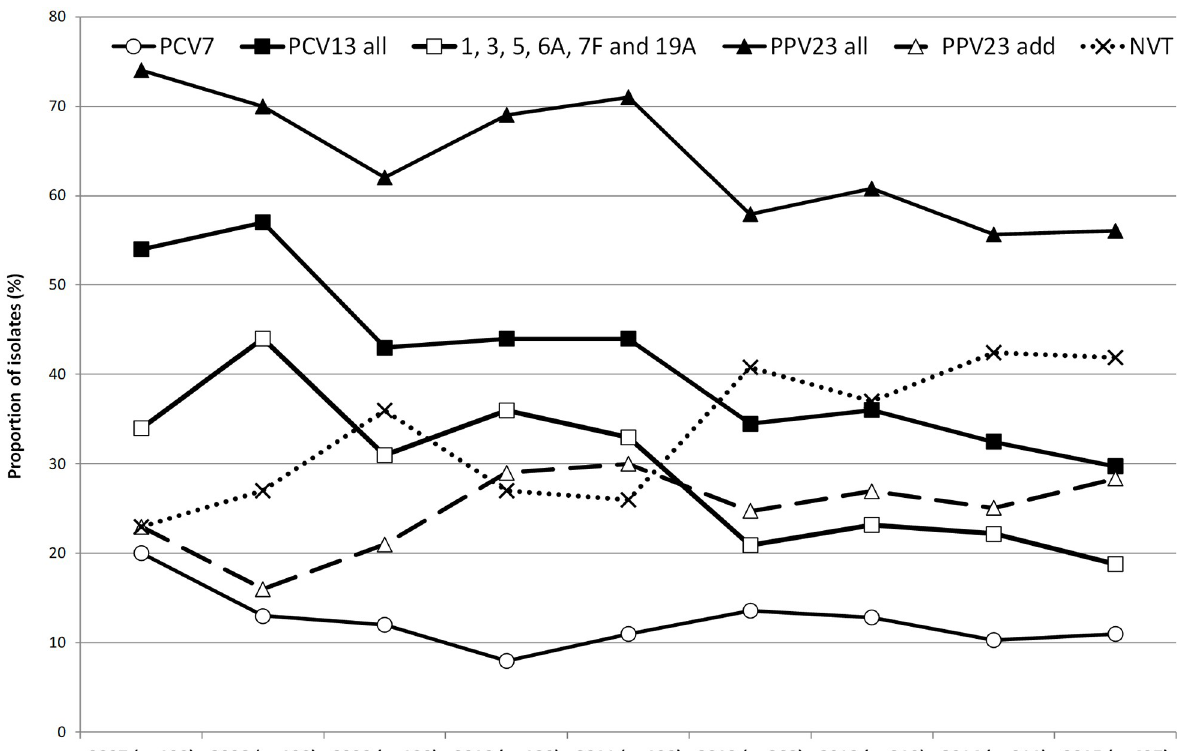
Fig 1. Proportion of isolates expressing serotypes included in each of the pneumococcal vaccines causing non-invasive pneumococcal pneumonia in adult patients ( � 18 years) in Portugal, 2007–2015. The data up to 2011 were presented previously